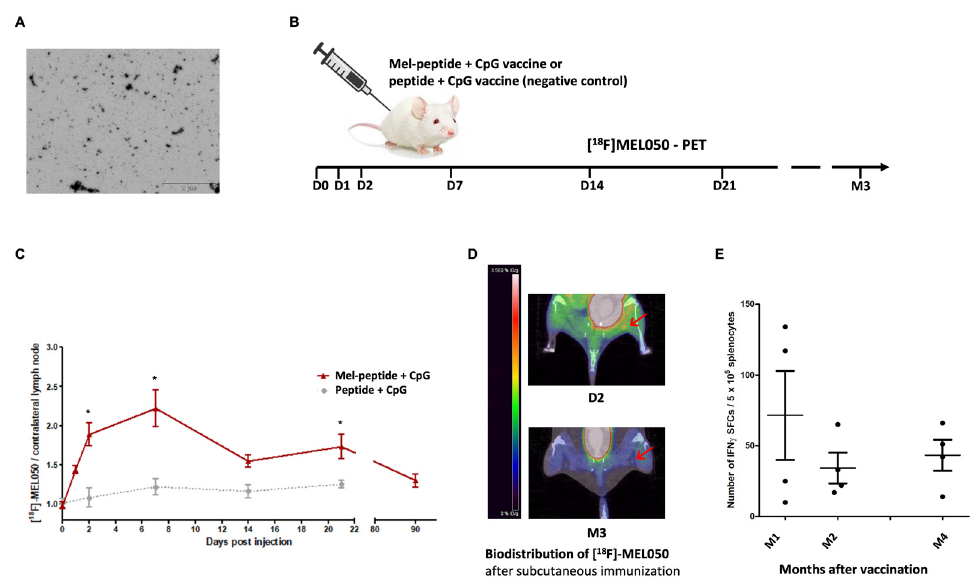
Figure 6. Biodistribution of pOVA30-Mel nanoaggregates after subcutaneous injection in mice. ( A ) Transmission electronic microscopy (TEM) image of peptide–melanin nanoaggregates (gp100). ( B ) Outline of the experiment: Balb/c mice were injected subcutaneously at the right hind leg with [pOVA30-Mel + CpG] or [pOVA30 + CpG] as negative control, and [ 18 F]MEL050 CT/PET imaging was performed 1, 2, 7, 14, and 21 days, as well as 3 months later. ( C ) Melanin–peptide kinetics in the right inguinal lymph node post-injection of the vaccine versus negative control, expressed as normalized values of [ 18 F]MEL050 (% ID/g) to background radioactivity (contralateral lymph node). ( D ) Representative images of the [ 18 F]MEL050 max signal into the right inguinal lymph node (red arrow), 2 days and 3 months post-injection of [pOVA30-Mel + CpG. ( E ) ELISpot analysis of splenocytes 1, 2, and 4 months after immunization with [gp100-Mel + CpG] vaccine (injections on days 0 and 14). Results are presented as mean ± standard error of the mean (SEM) (data of four mice per group pooled from two different experiments); Mel = melanin; * = p < 0.05.